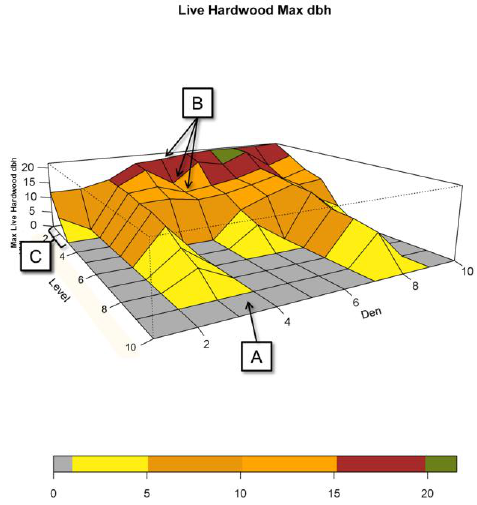
Figure 2. Example of NCs of size k = 10 plots (10-Max) that contain den sites where plots within each NC are ranked from l = 1 to 10. The Den axis represents 10 such den NCs. The Level axis represents the ranked plots within each NC from best (1) to worst (10). ( A ) shows the lowest ranked areas that have low attribute measures; The “topography” ( B ) represents the size of Maximum Live Hardwood, dbh, found across plots within each NC. The color scale represents the size of the largest live hardwood in a given plot based upon the diameter at breast height (measured in inches); ( C ) shows the top 3 ranks.